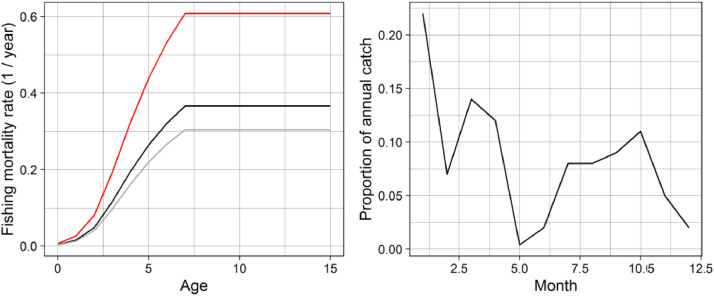
Left panel: Mean historical F at age (2001 to 2018, black line) from which FMSY is calculated with a multiplier of 0.83 (grey line) and Flim with a multiplier of 1.66 (red line). Right panel: Proportion of annual catch in each month over the historical period which is used to apportion F over each year in SEASIM-NEAM.